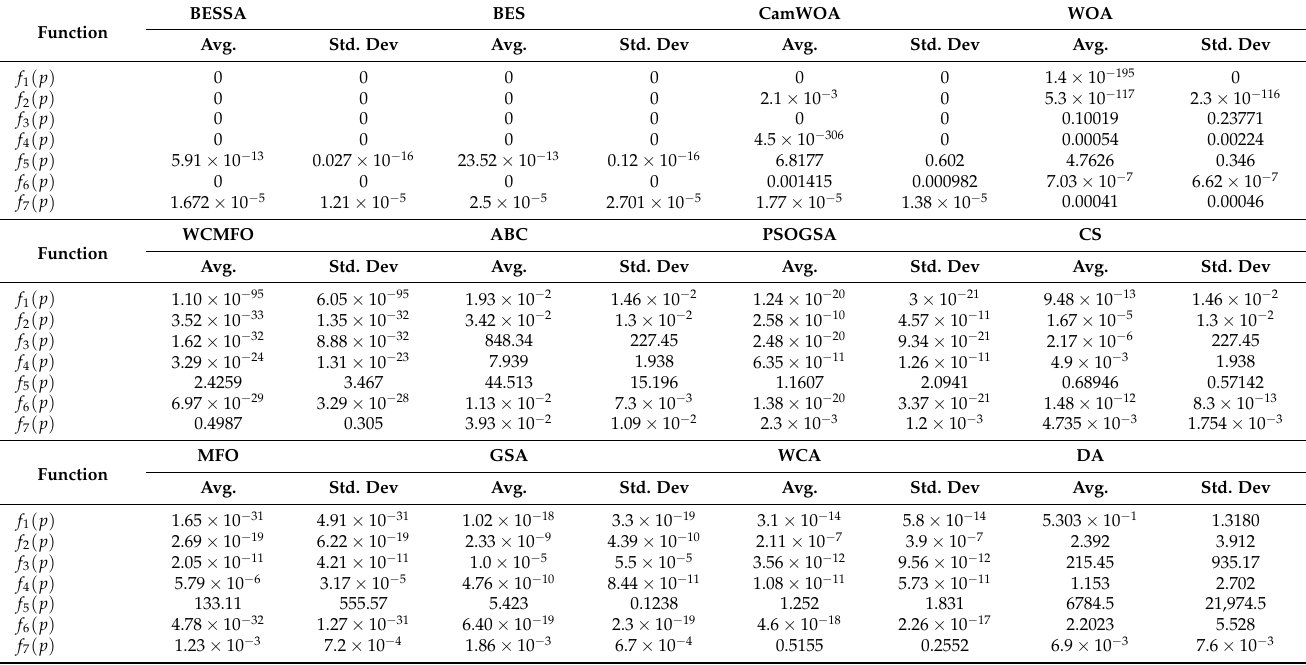
Table 2. Statistical results for unimodal